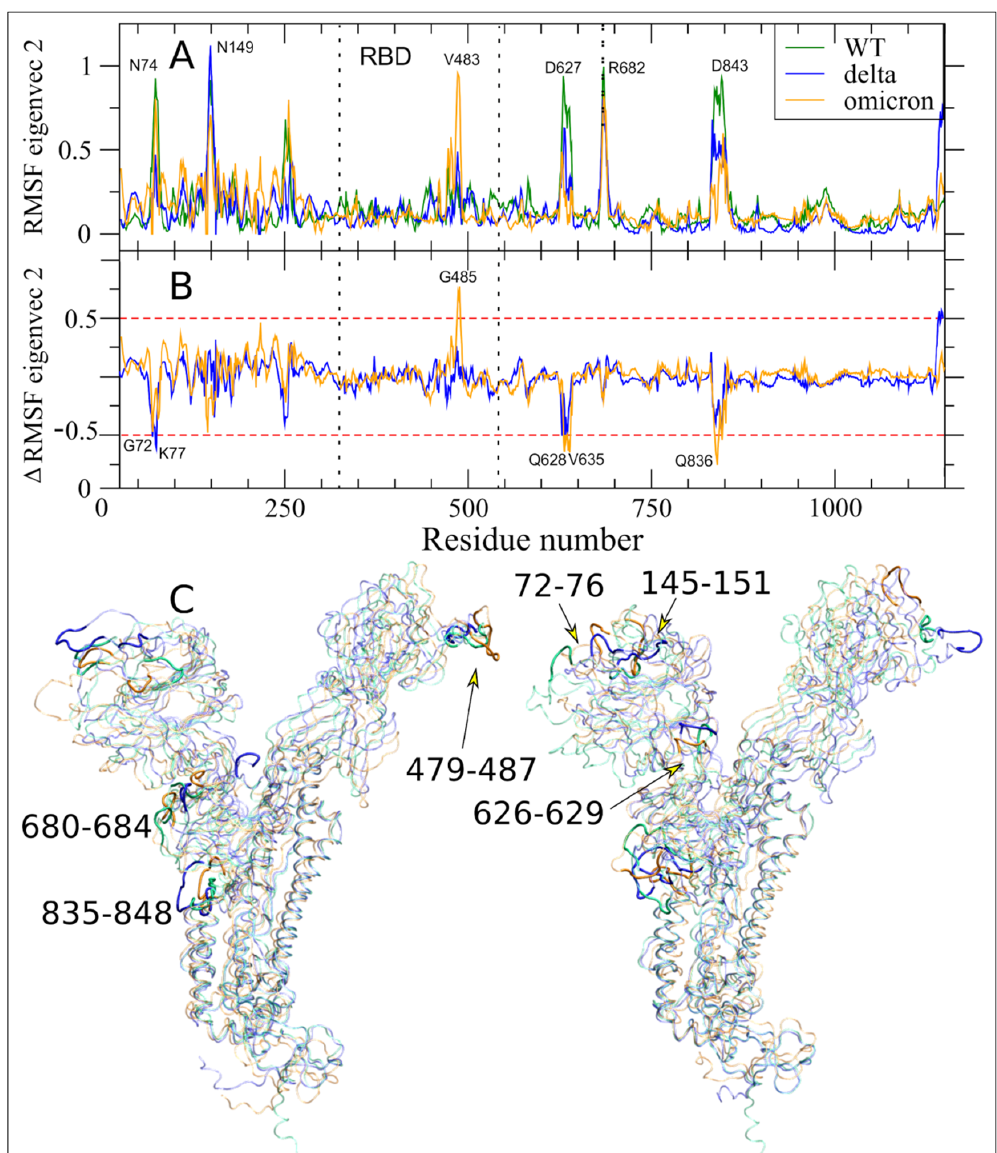
Figure 5. Long-range correlated motions along Essential Dynamics V2. ( A ) RMSF of the S protein filtered trajectory along V2 for WT, Delta, and Omicron variants are reported in dark green, blue, and orange colors, respectively. The residues corresponding to fluctuation peaks along V2 are indicated. ( B ) The difference between the filtered RMSF along V2 between Delta and Omicron as compared to the WT are reported in blue and orange colors, respectively. Residues above the threshold of |±0.5 nm| (dashed red lines) are indicated. ( C ) Extreme projections of the S protein MD trajectory along V2 for WT, Delta, and Omicron variants are in transparent mode and green, blue, and orange colors, respectively. The six regions showing the long-range correlated movements along this ED eigenvectors are in opaque mode and their residue range is reported.